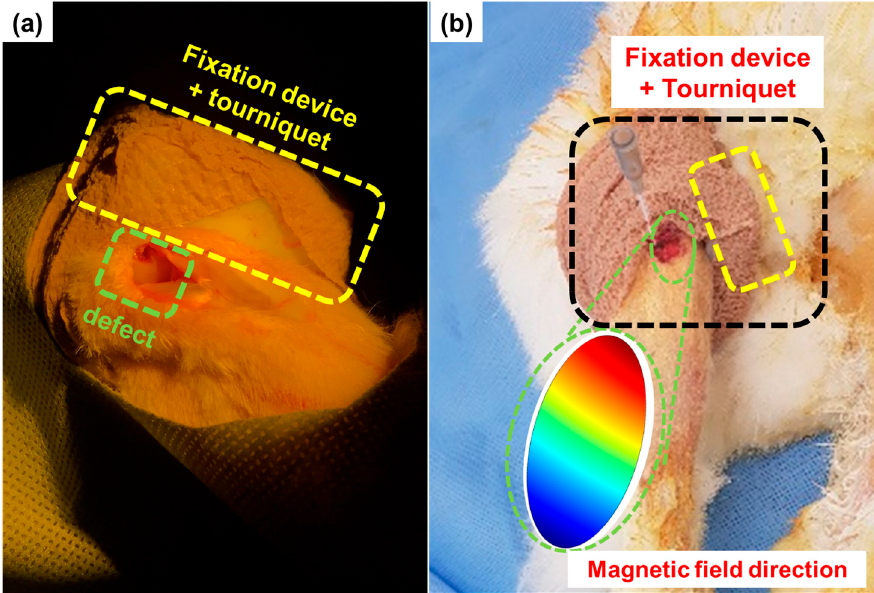
Figure 9. In-vivo experimental setup, where the fixation device is wrapped around the upper part of the knee of the animal subject: ( a ) fixation device secured on the rabbit using a tourniquet and ( b ) magnetic field at the defect due to the fixation device.